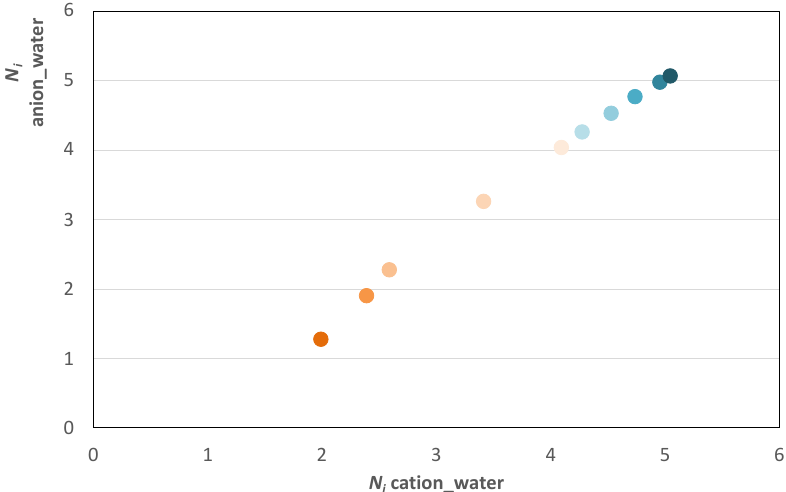
Figure 17. Average number of neighbors around the cation ( N i cation_water) vs. the anion ( N i anion_water) in aqueous solutions of [N 1 2OH 2OH 2OH ][NTf 2 ].